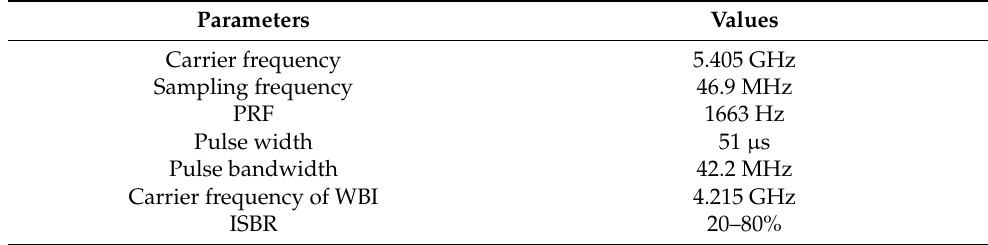
Table 1. Main system parameters of the